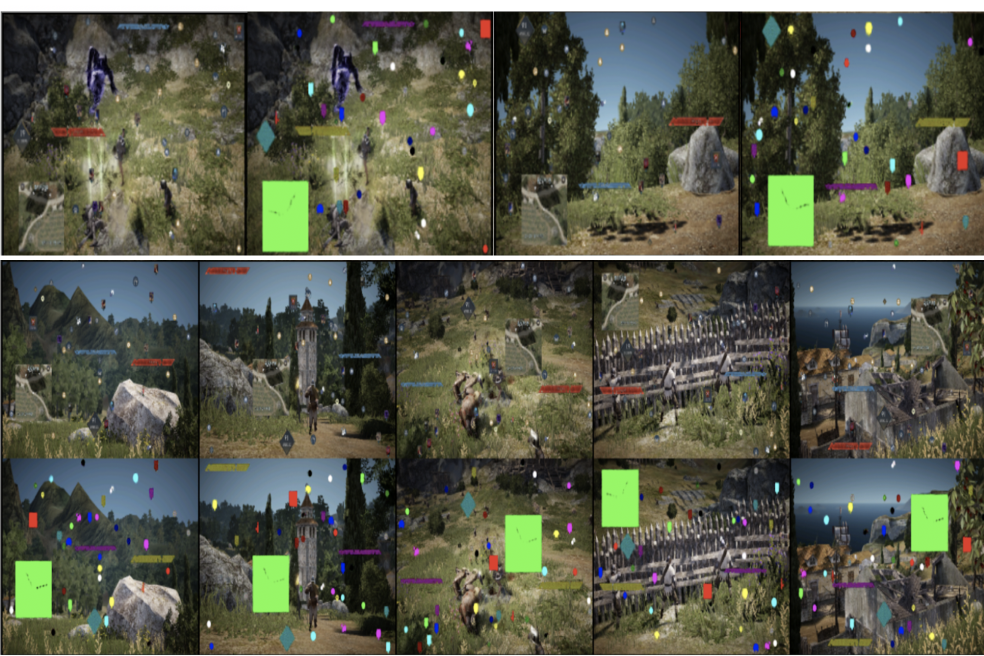
Figure 11. Result of Black Desert UI segmentation.